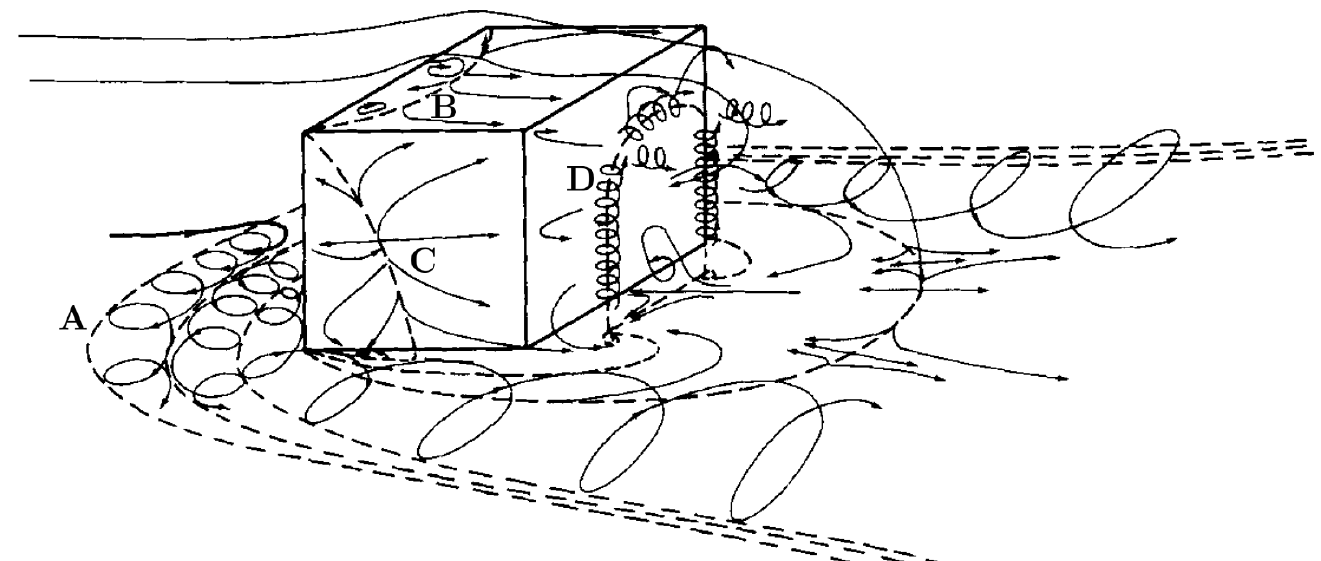
Figure 8. Illustration of the main vortical structures around a surface-mounted obstacle, i.e., the horseshoe vortex ( A ), the roof vortex ( B ), the vortices on the obstacle side ( C ) and the arch vortex ( D ). Adapted from Ref. [128], with permission of the publisher (Cambridge University